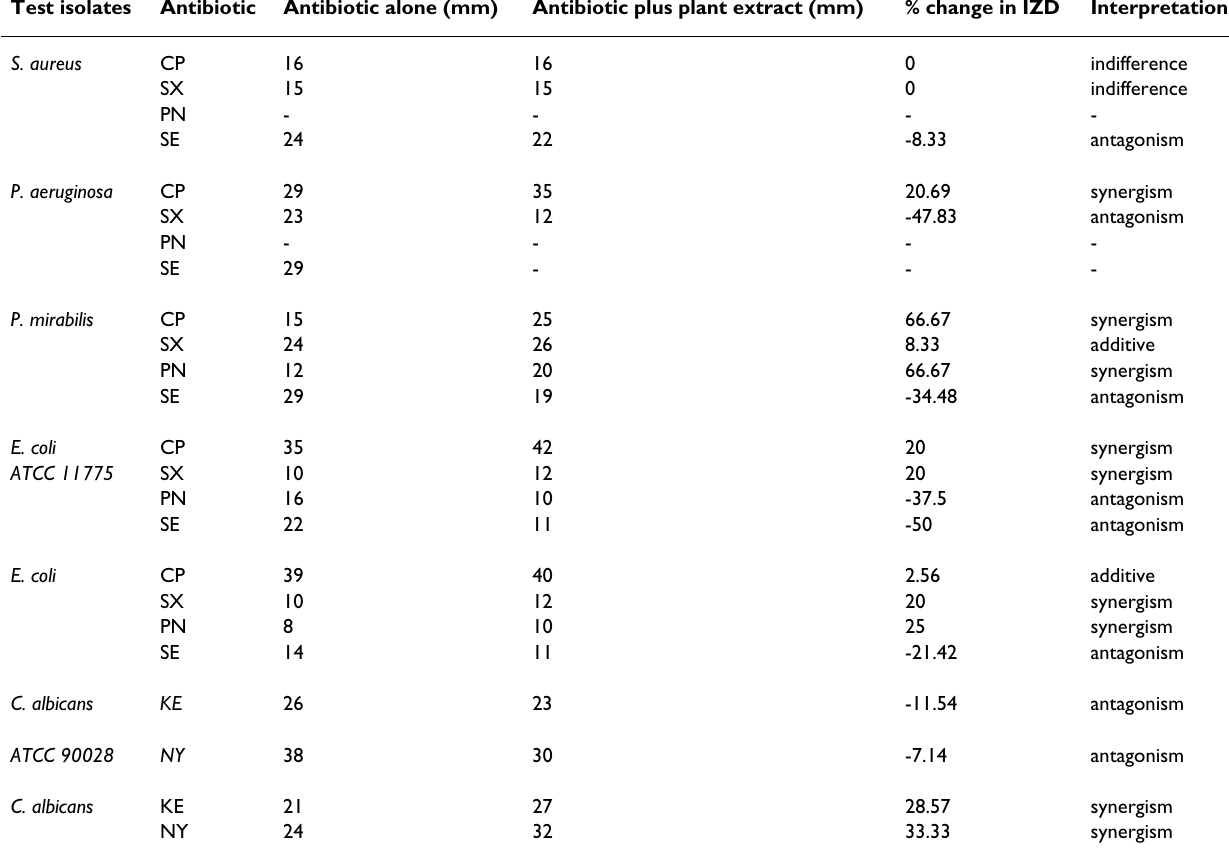
Table 3: Summary of the interaction of the plant extract and the various antibiotics Test